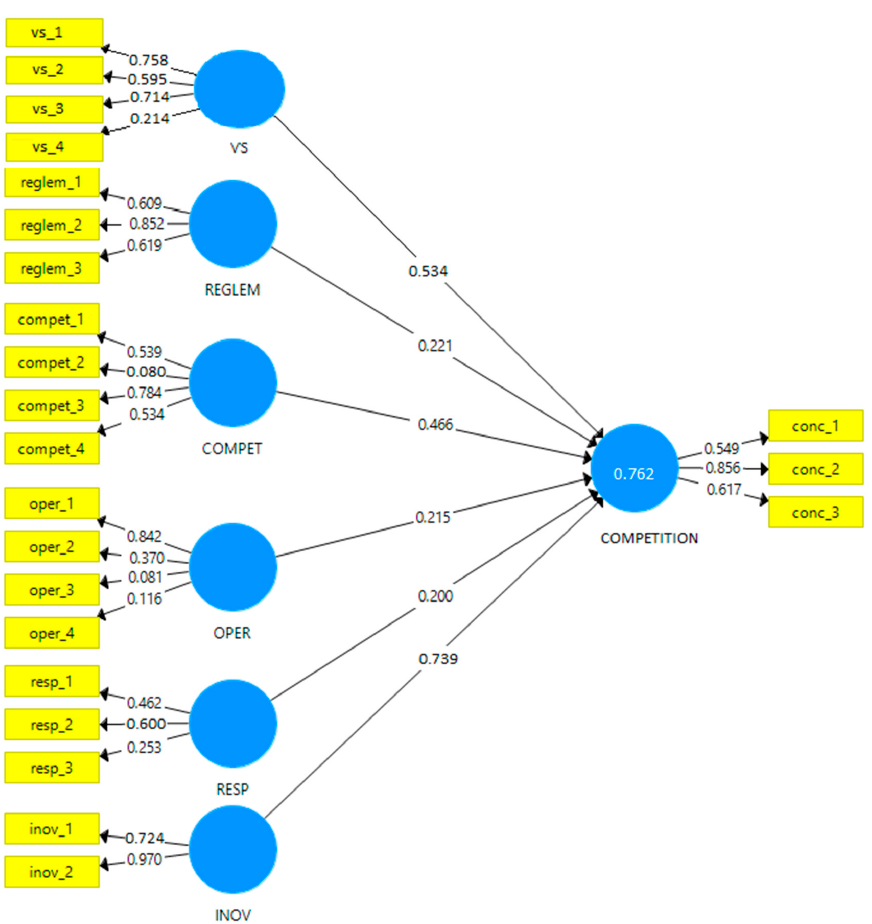
Figure 3. Measurement PLS-SEM 1 model. Source: Data analysis was performed by the authors using the SmartPLS software 3.2.8.